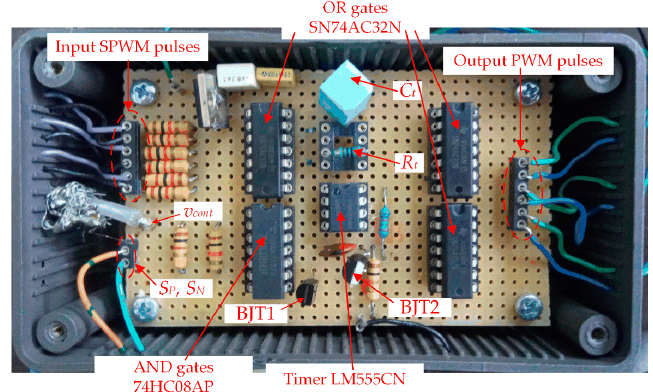
Figure 7. Photo of the electrical circuitry utilized for the STSs injection.